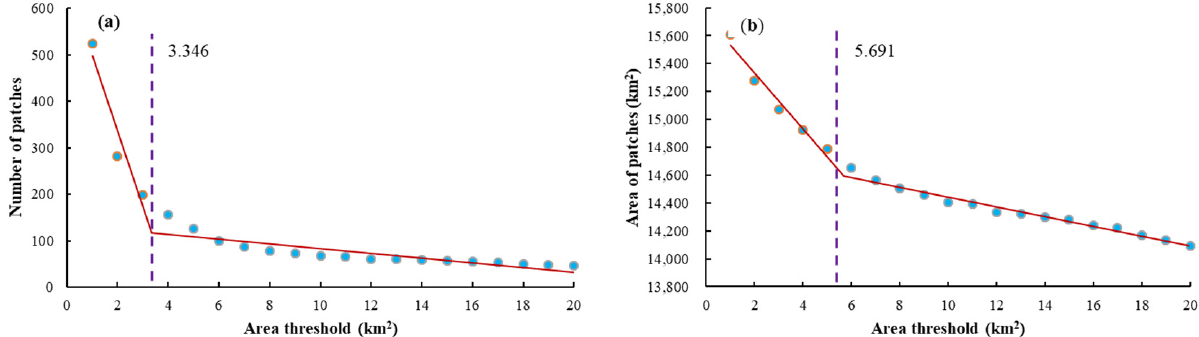
Figure A1. Number ( a ) and area ( b ) of ecological sources under different area thresholds in 2000.